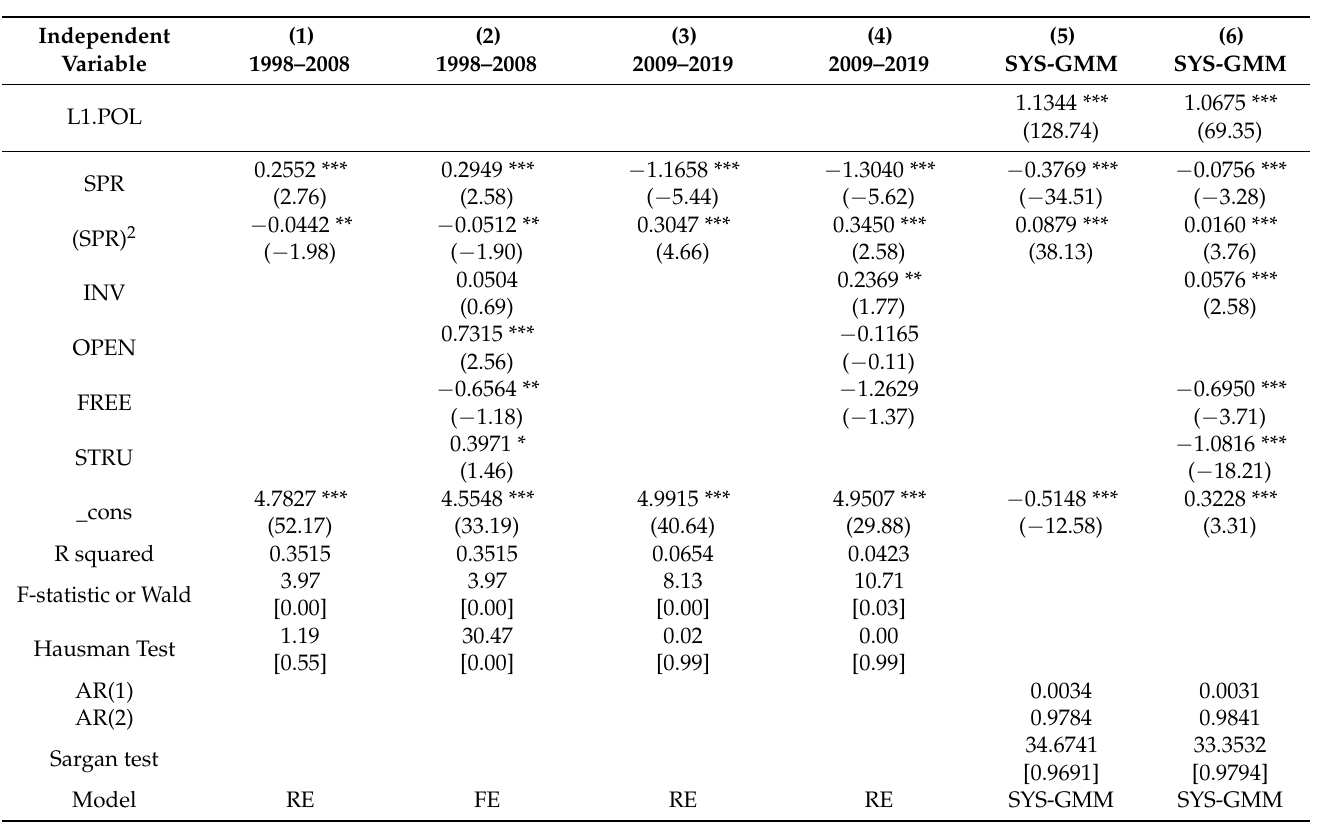
Table 8. Robustness